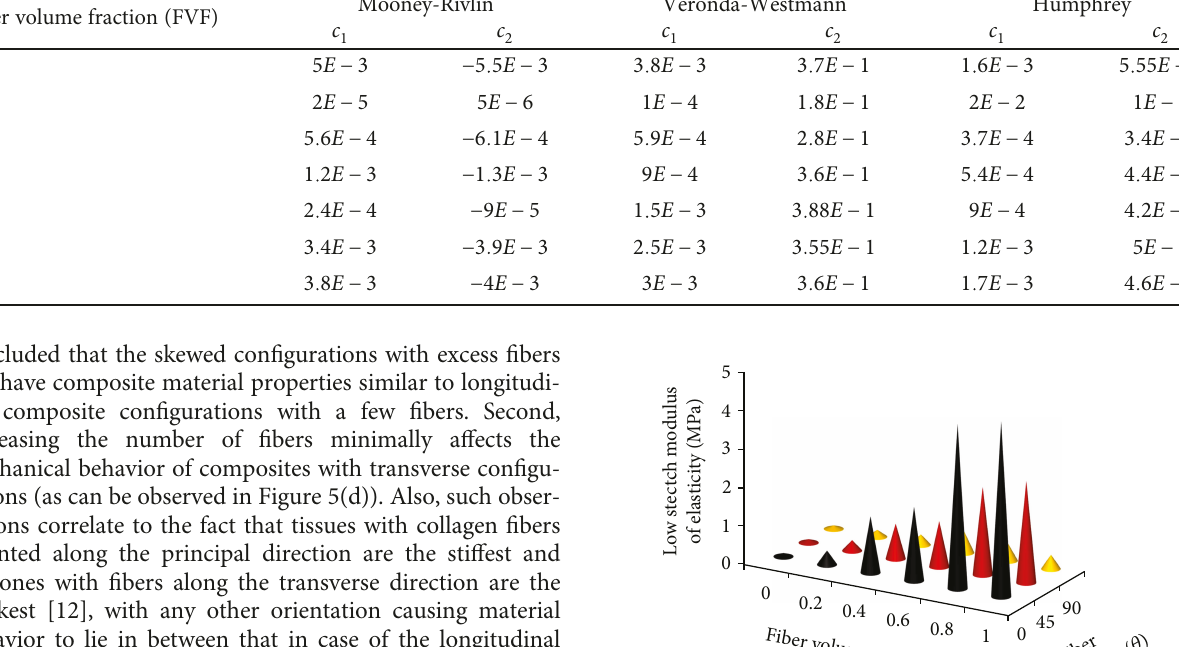
Table 1: Hyperelastic curve fi t coe ffi cients for the soft composite materials developed with varying FVFs (presented in Figure 5(a)). Fiber volume fraction (FVF)